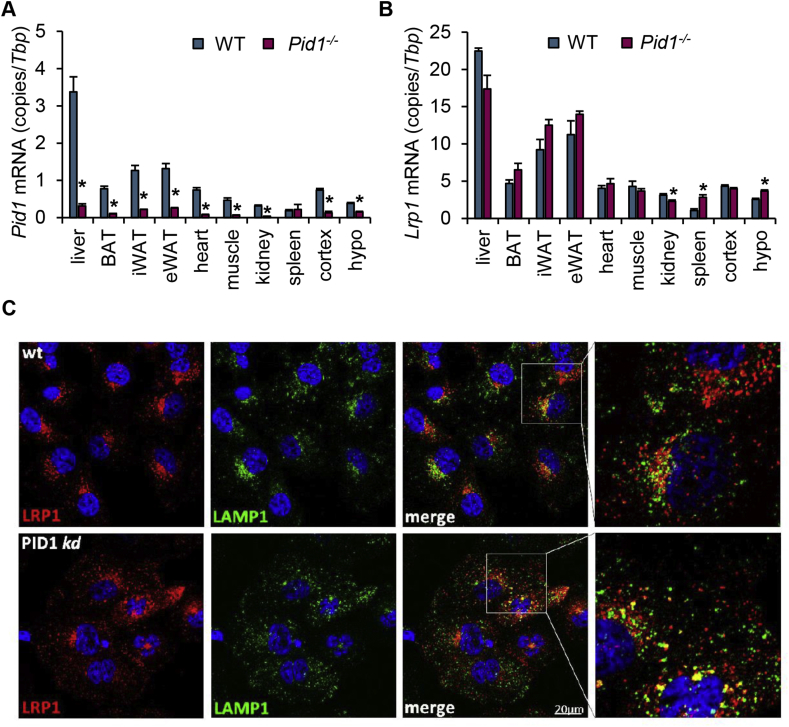
mRNA expression of PID1 and LRP1 in wild type and Pid1−/−mice. (A) Pid1 and (B) Lrp1 mRNA expression levels in different organs of WT and Pid1−/− mice. Copy numbers were normalized on the expression of the housekeeping gene TATA-box-binding-protein Tbp. (BAT, brown adipose tissue; iWAT, inguinal white adipose tissue; eWAT, epididymal white adipose tissue; hypo., hypothalamus). Mean values ± s.e.m. with n ≥ 5 are shown. *P < 0.05. (C) Human HuH7 hepatoma cells were transduced with lentiviruses expressing either shRNA targeting human PID1 (PID1 kd) or a scrambled control shRNA (wt). Indirect immunofluorescence was performed to visualize endogenously expressed LRP1 (red) and LAMP1 (green). Nuclei were stained using DAPI (blue). Bar: 20 μm.